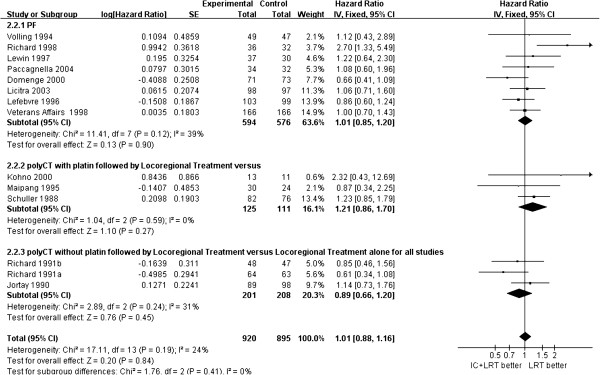
Forest plot of hazard ratios for overall survival and 95% CI in fourteen randomized controlled trials in patients with resectable head and neck squamous cell carcinoma treated with induction chemotherapy followed by locoregional treatment, or locoregional treatment alone. Richard 1991a23 is for cancer of the floor of the mouth, Richard 1991b23 is for cancer of the posterior oral cavity and oropharynx. Volling 199413, Richard 199827, Lewin 199714, Paccagnella 200411, Domenge 200015, Licitra 200316, Lefebvre 199624, Veterans Affairs 199827, Kohno 200021, Maipang 199519, Schuller 198820, Jortay 199022.